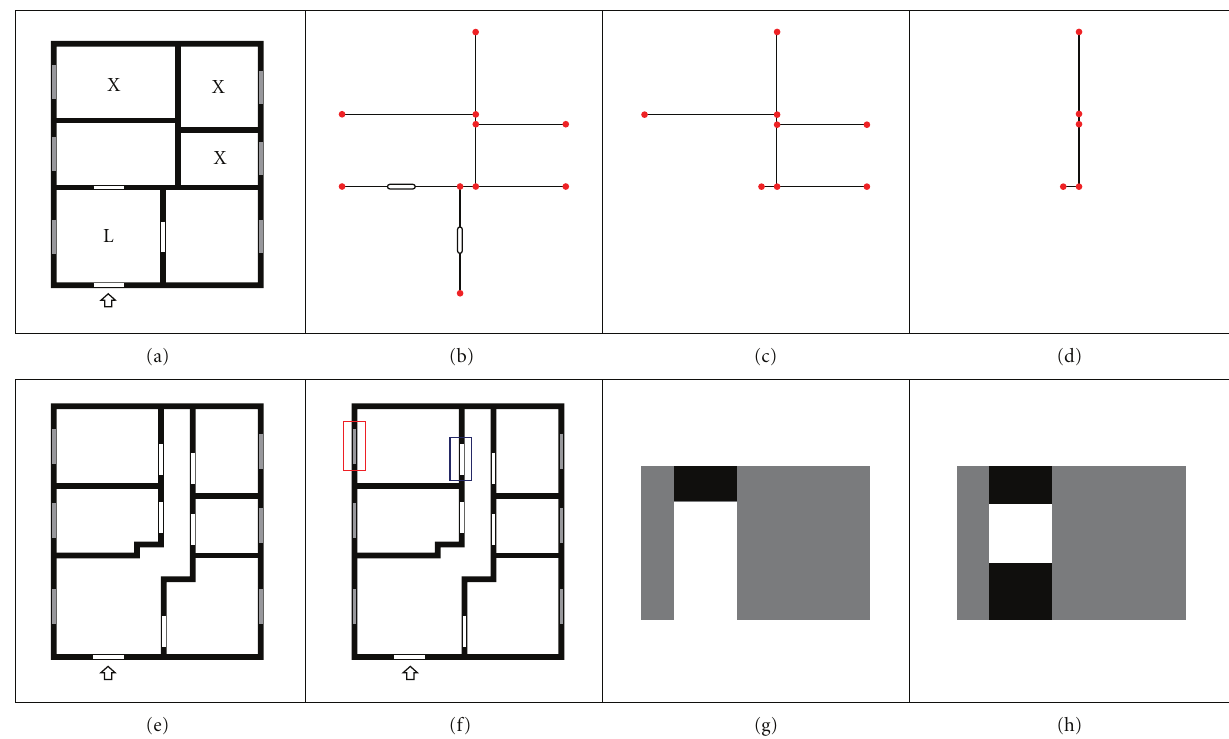
Figure 8: Steps to end the building generation. (a) Original floor plan with rooms without connectivity flagged with an X and the living room is marked with L. (b) Floor plan after external edges removed. (c) Internal walls that do not belong to living room. (d) The shortest path linking all rooms without connectivity to the living room. (e) Final 2D floor plan. (f) The red and blue rectangles highlight, respectively,